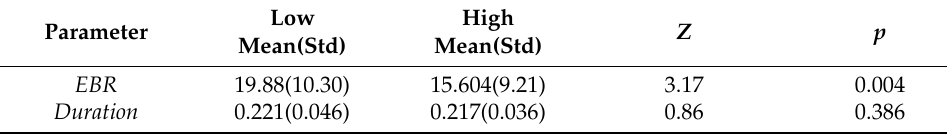
Table 2. Wilcoxon Signed-Rank Test results for eye blinks parameters.